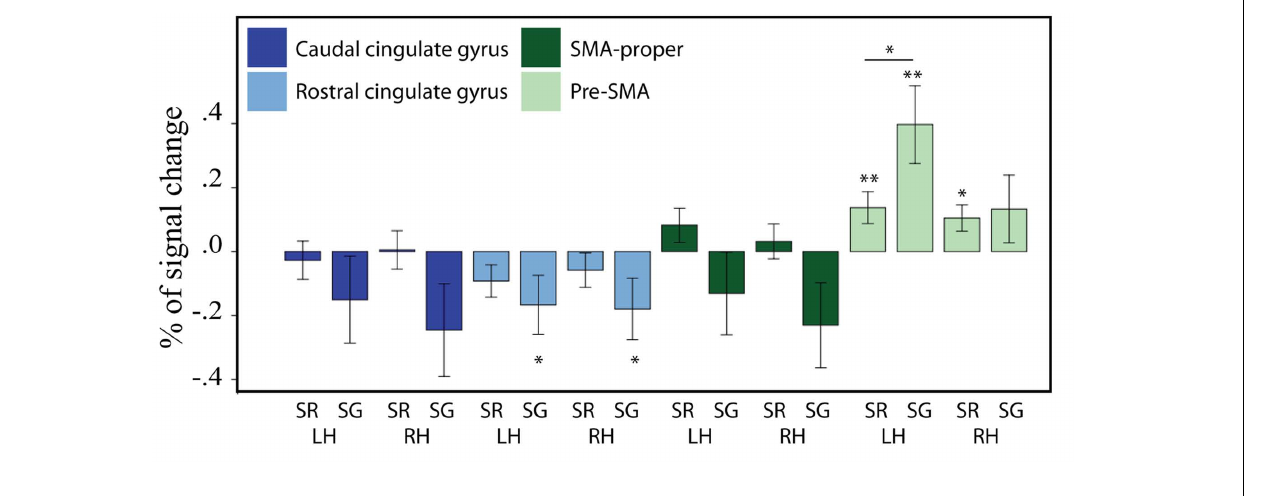
FIGURE 4 | Brain activity (expressed as a percentage of signal change) for sentence repetition (SR) and sentence generation (SG), for the medial frontal ROI group. LH = left hemisphere, RH = right hemisphere. From left to right: caudal cingulate gyrus (left, right), rostral cingulate gyrus,